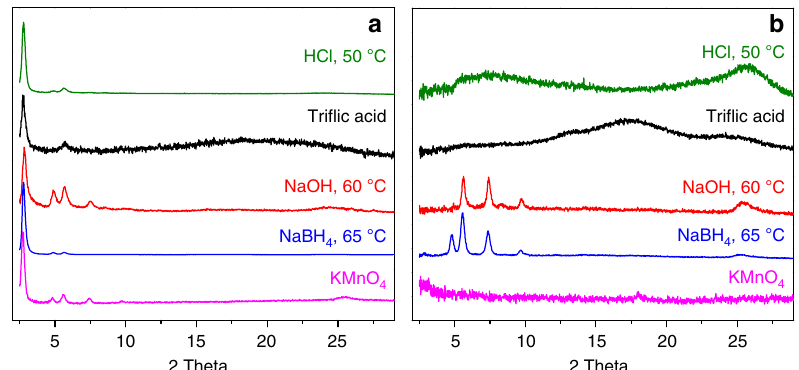
Fig. 4 Chemical stability of MF-1a and COF-1. PXRD patterns of MF-1a ( a ) and COF-1 ( b ) after treatment with 12 M HCl at 50 °C for 8 h (green), 98% tri fl ic acid at ambient temperature for 3 days (black), 14 M NaOH in H 2 O/MeOH solution at 60 °C for 1 day (red), 5 equiv. of NaBH 4 in MeOH at 65 °C for 1 day (blue), and 5 equiv. of KMnO 4 in H 2 O/CH 3 CN solution at ambient temperature for 1